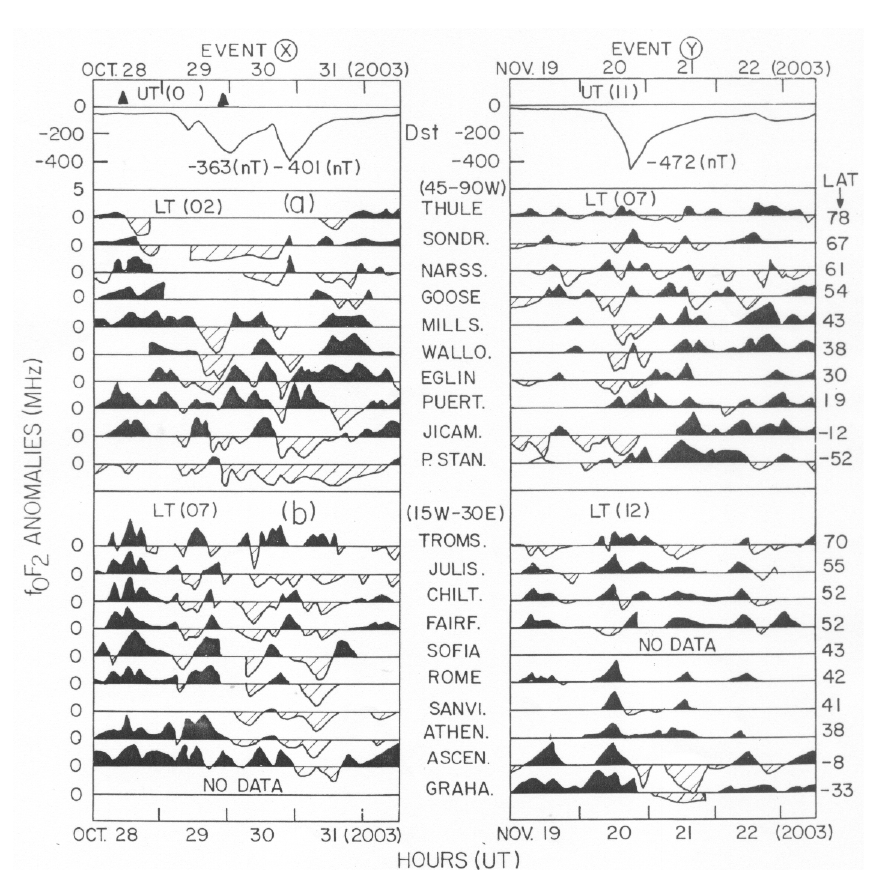
Fig. 2. Plots for Event X (28–31 October 2003) in the left half and Event Y (19–22 November 2003) in the right half, for D st (top plots) and the f o F2 anomalies (MHz) for stations in different latitudes (north to south, indicated on the right) and longitude belts, (a) 45 ◦ W–90 ◦ W, (b) 15 ◦ W–30 ◦ E. Vertical lines mark the storm commencements. Positive deviations are painted black, negative deviations are shown as